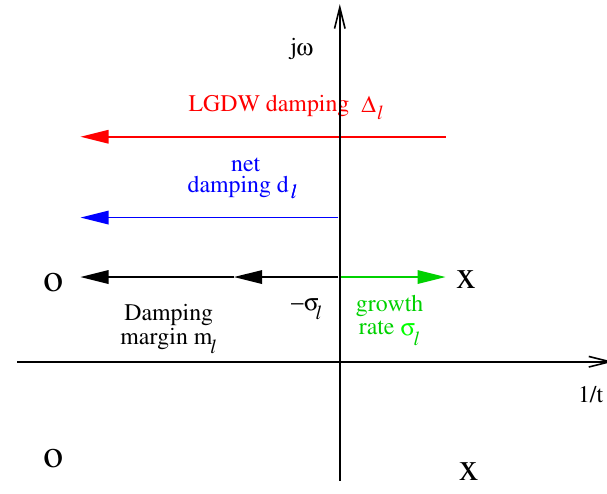
FIG. 10. (Color) Damping margin definition.